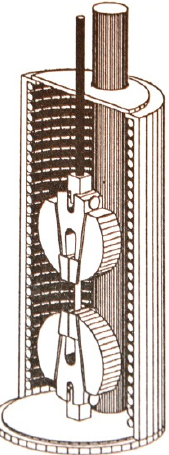
Figure 5. The cylindrical heating chamber for elevated temperature testing.